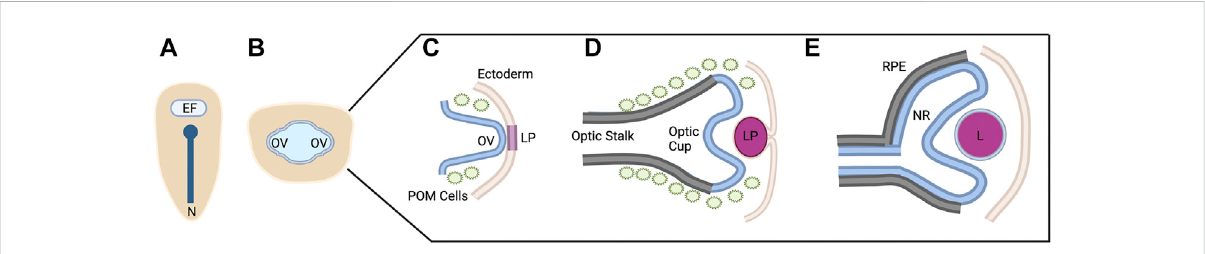
FIGURE 1 Vertebrate Ocular Development. Schematic representation of ocular development stages from eye fi eld speci fi cation to bi-layered optic cup formation (A – E) . This process occurs between 12 and 24 hpf in zebra fi sh, E8-10 in mouse, and from ~4 to 7 weeks in human. See text for process details.EF,eye fi eld;N,notochord;OV;opticvesicle;LP,lensplacode/pit;POM,periocularmesenchyme;RPE,retinalpigmentepithelium;NR,neural retina; L, lens. Figure created with